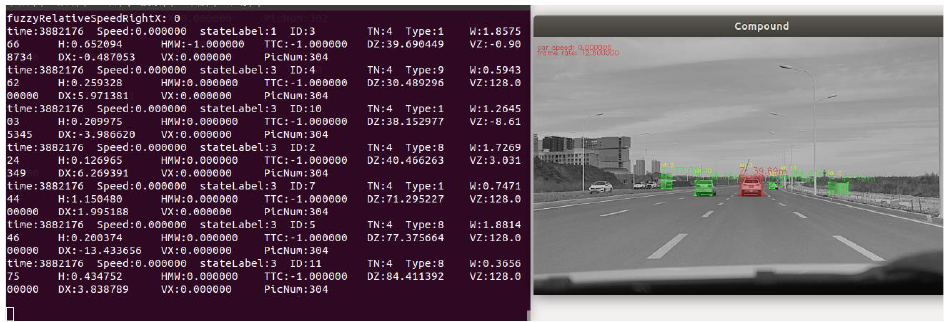
Figure 13. Acquisition of data during actual vehicle verification.